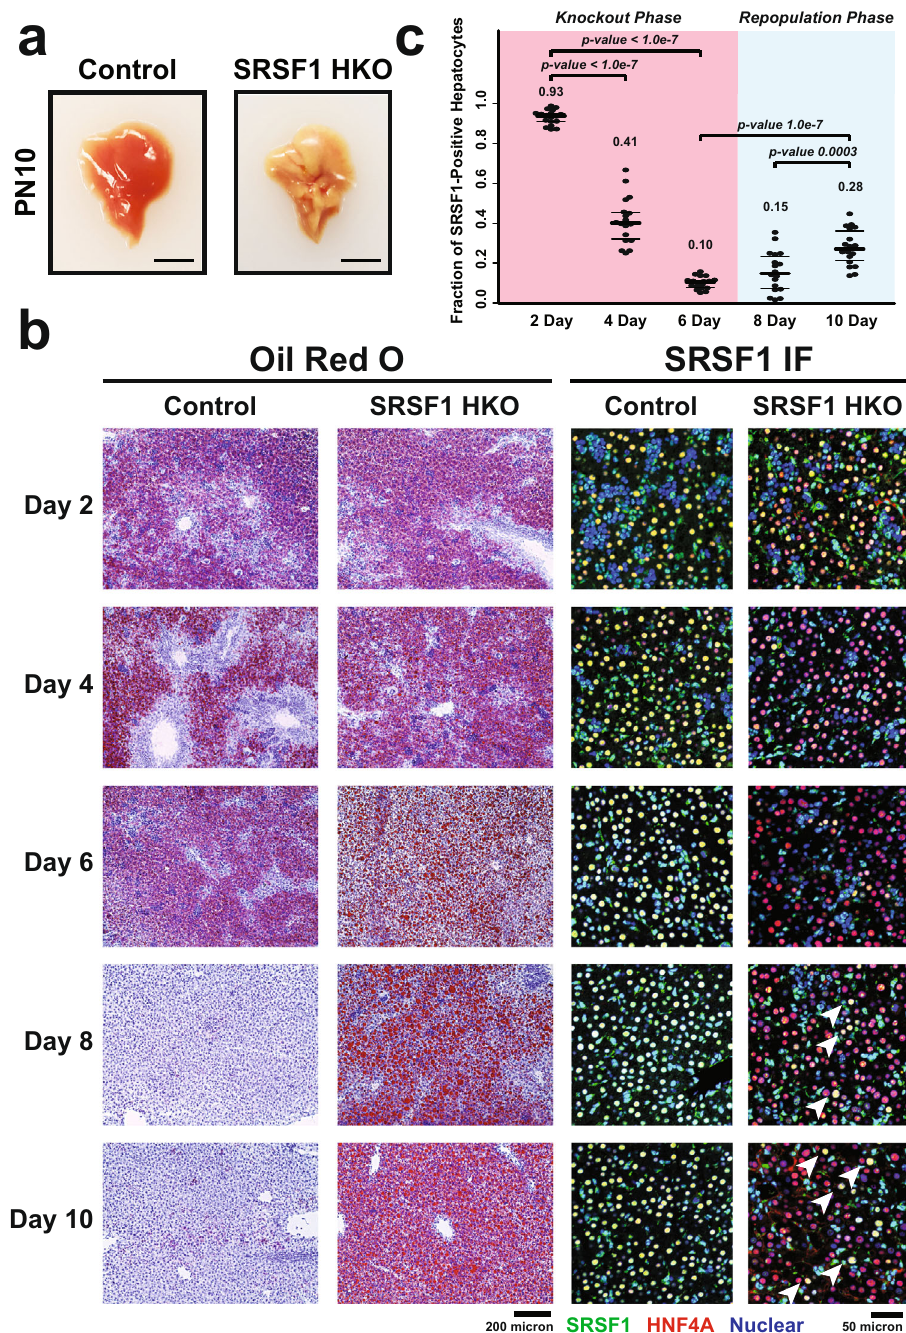
Fig. 1 | Knockout of SRSF1 in hepatocytes triggers a regenerative response. a Representative gross images of livers harvested from Control ( AlbCre +/ − ) and SRSF1 HKO ( SRSF1 fl ox/ fl ox ; AlbCre +/ − ) mice 10 days after birth ( n =6 biologically independent animals per group). Scale bar = 1cm. b Representative histological (OilRedO)andimmuno fl uorescence(IF)imagesofliversectionsfromControland SRSF1 HKO mice at indicated timepoints ( n =3 biologically independent animals per group, 6 fi elds per replicate). IF images show co-staining with SRSF1 (green),